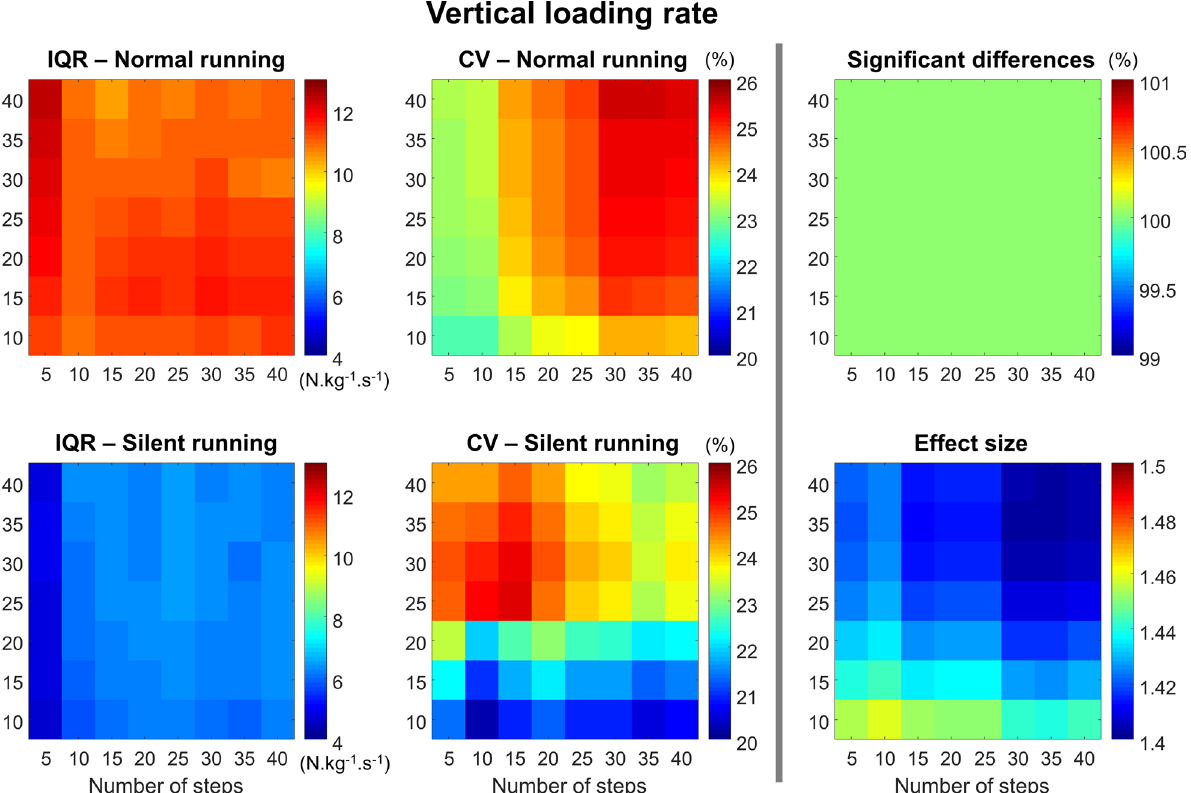
Figure 9. Colormaps demonstrating vertical loading rate interquartile range (IQR, left column ) and coefficient of variation (CV, central column ) from the combination of 10–40 runners versus 5–40 running steps. Data is shown from normal running ( top panels ) and silent running ( bottom panels ). Each value is an average from 100,000 paired permutations for each combination. The number of significant differences ( p < 0.05, expressed as a percentage of 100,000 comparisons, top right panel ) and their respective effect size ( bottom right panel ) illustrate the changes in statistical outcomes depending on the combination of number or runners vs number of